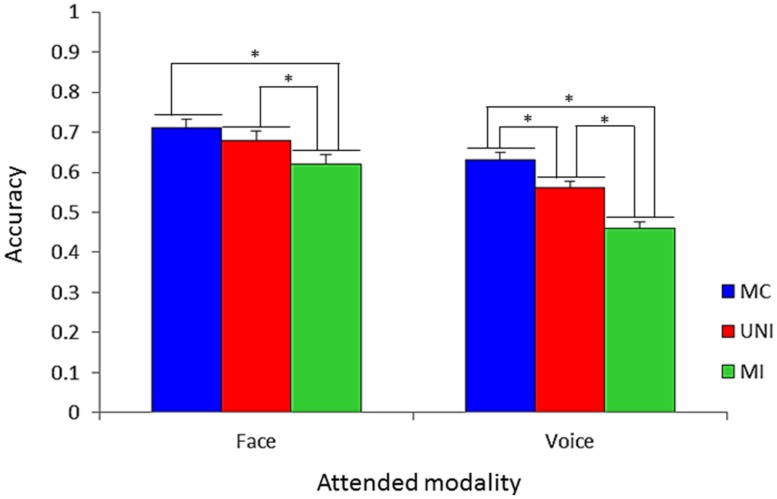
Accuracy on all presentation conditions with respect to attended modality for all emotion categories. Error bars represent SE (*p < 0.05).